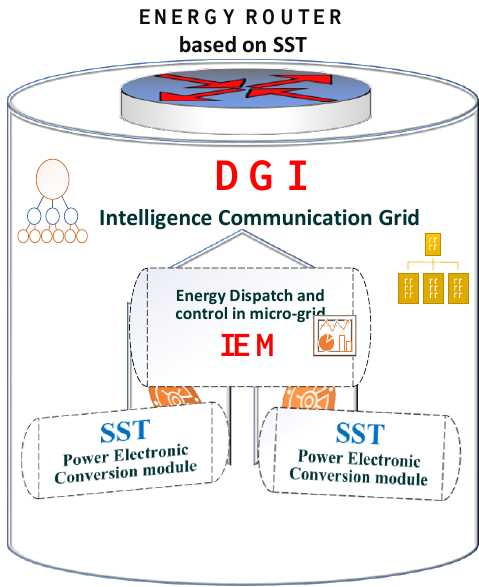
Figure 5. Organization of an energy router (ER) in a FREEDM structure. DGI—distributed grid intelligence.